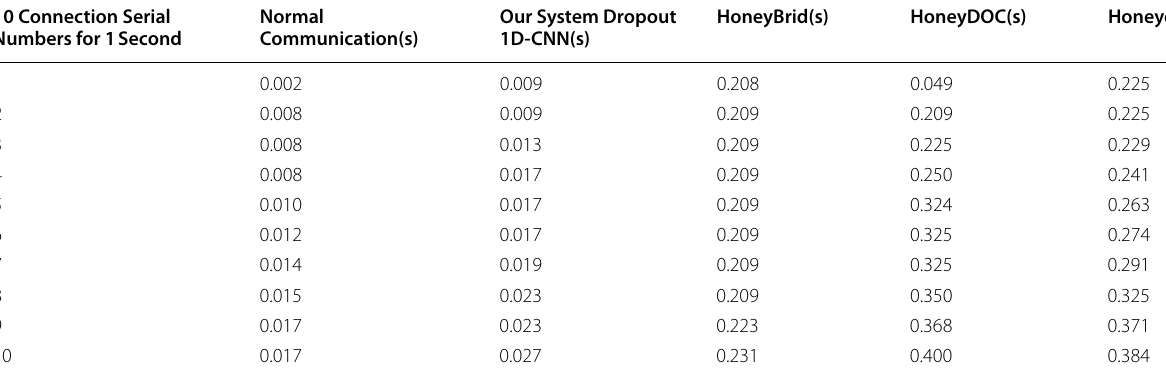
The experimental results again demonstrate that the TCP_REPAIR-based connection switching latency in this system is much lower than using TCP replay and NAT address translation